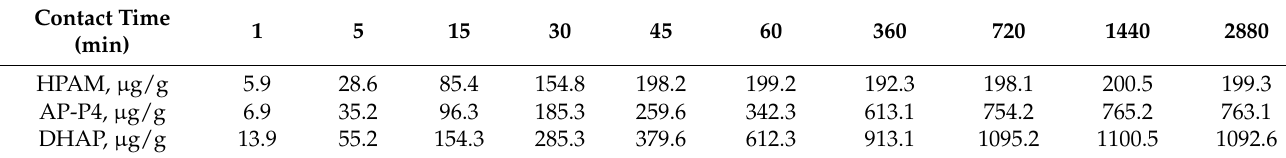
Table 4. Effect of contact time on polymer adsorption capacity.